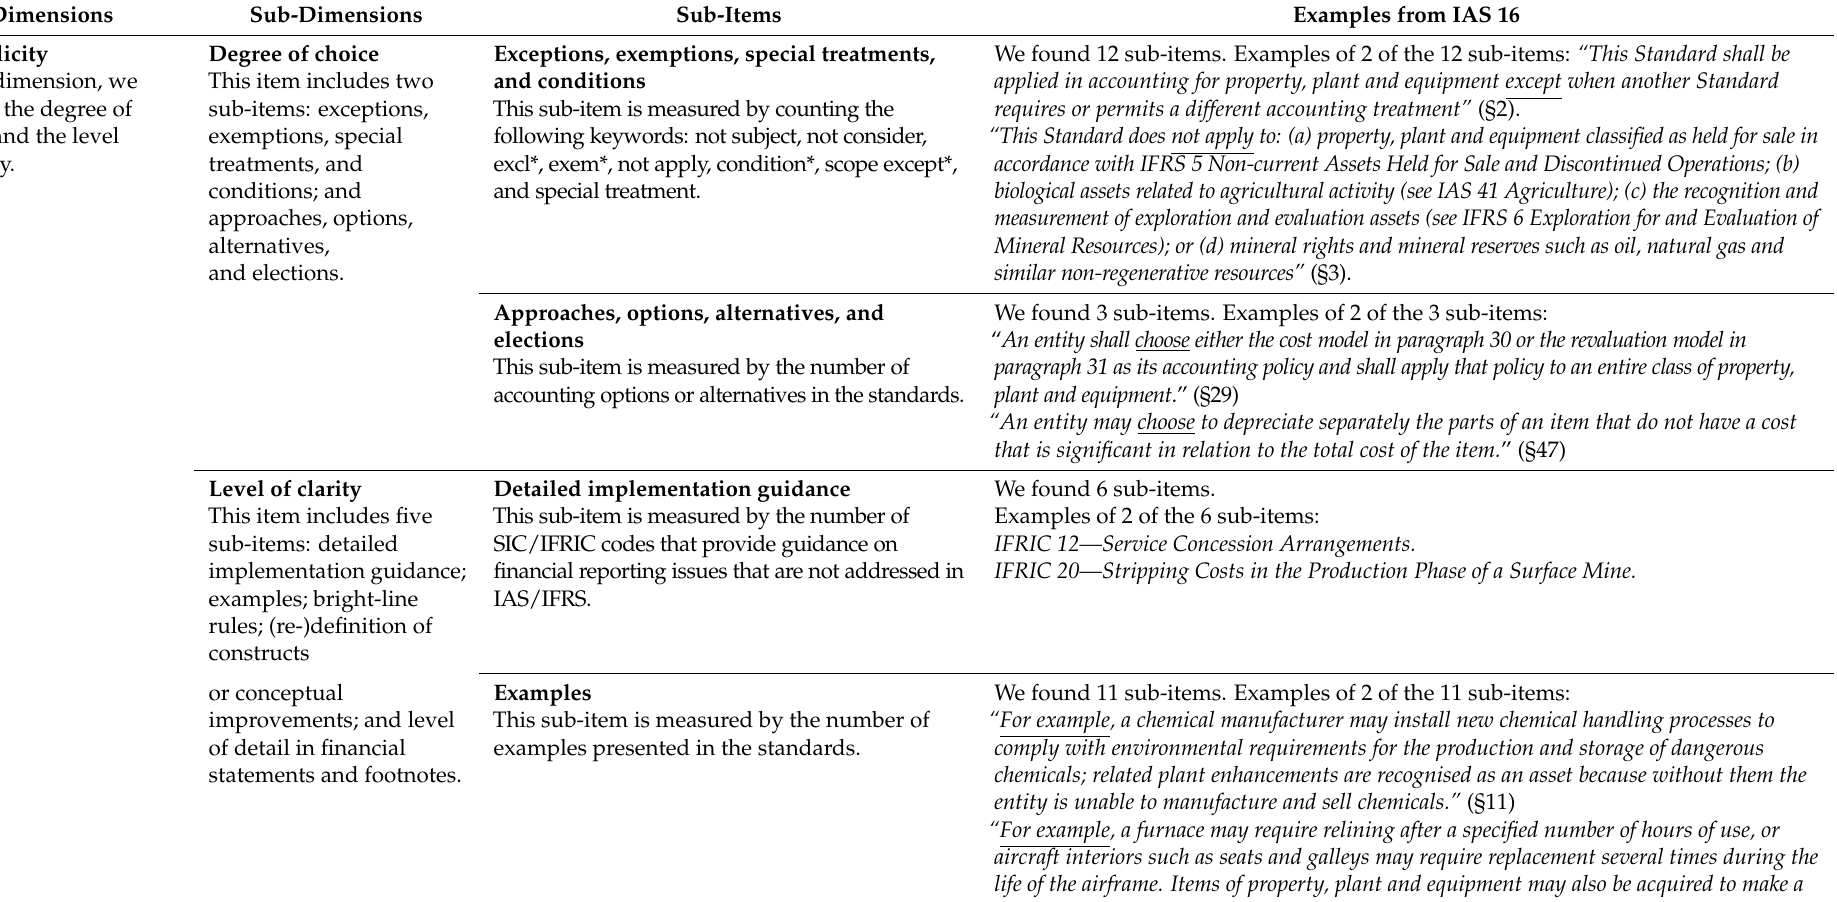
Table 1. Example of the Calculation of the Score, Which Measures the Complexity in an Accounting Standard—IAS 16: Property, Plant and Equipment.